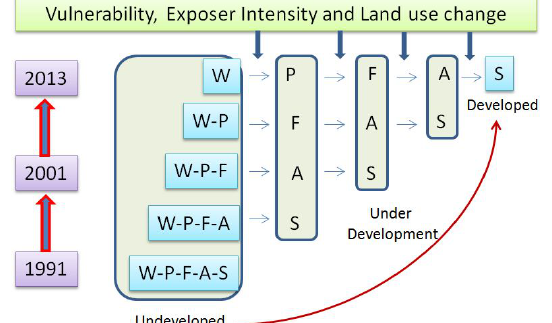
Figure 6. Transformation of five land cover classes over past 3 decades. S = Settlements, A = Agriculture, F = Forest, P = Pasture, W =